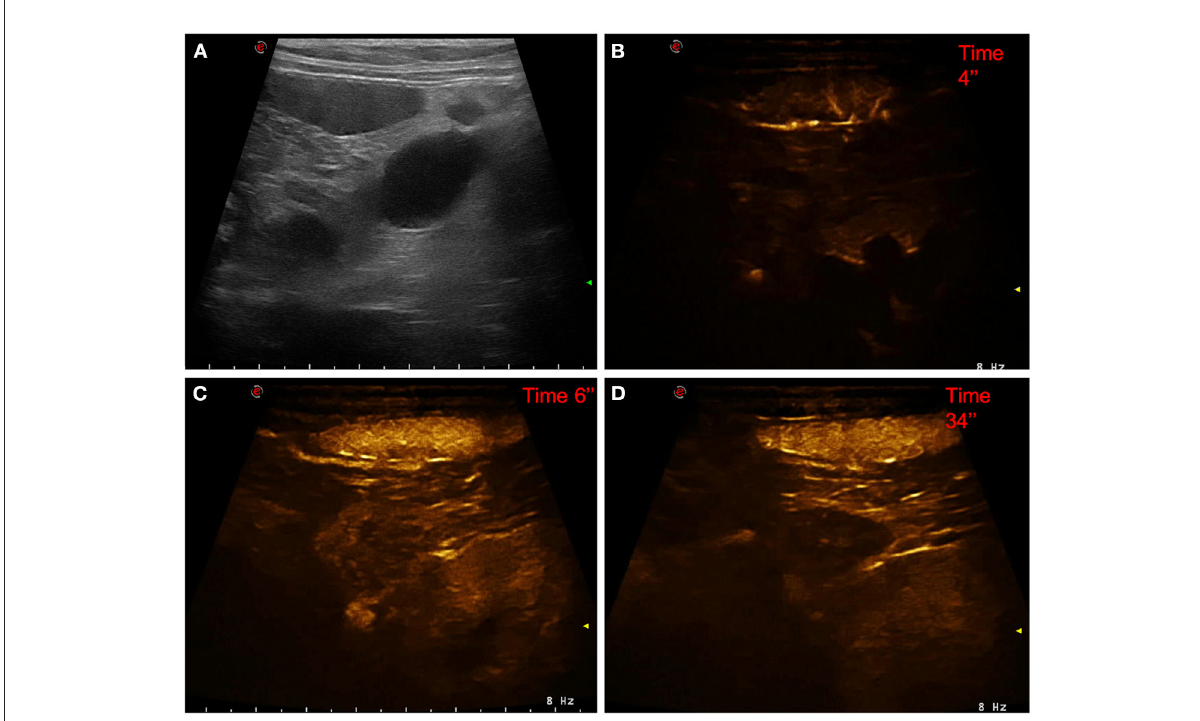
FIGURE2 Example of a lymphoma showing: no pseudocystic appearance, hypoechogenicity, presence of acoustic enhancement, and presence of peripancreatic reactivity at US; hyperenhancement, diffused and inhomogeneous distribution of contrast medium, absence of intralesional microcirculation, and absence of hypoperfused areas during wash-in at CEUS; hypoenhancing, inhomogeneous and diffused wash-out. (A) Image obtained from US examination; (B) image obtained at TTE; (C) image obtained at TTP; (D) image obtained during